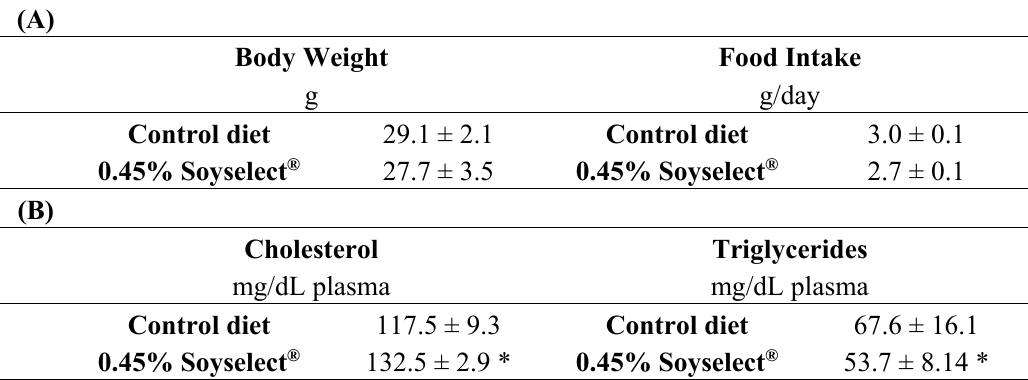
Table 1. Body weight and food intake ( A ) and cholesterol and triglyceride circulating concentrations ( B ) in controls and in mice fed a 0.45% Soyselect ® diet.